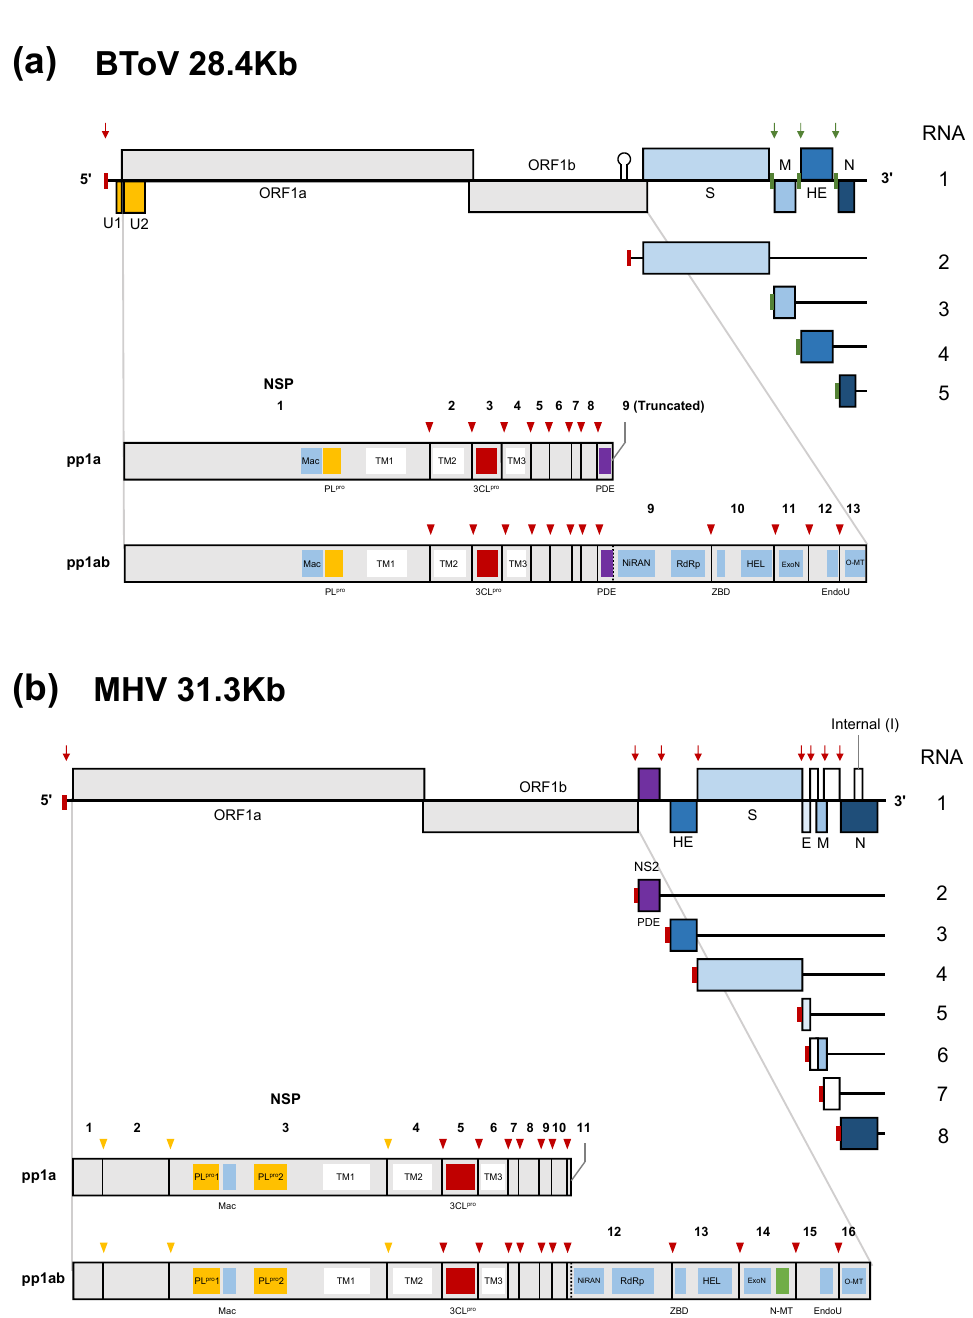
Figure 2. Genome organisation and gene expression of ( a ) BToV and ( b ) MHV (lineage A beta-CoV). The subgenomic (sg) mRNA species are numbered from large to small, with the genome designated RNA1. BToV and MHV polyprotein processing of pp1a and pp1ab and the conserved domains of nonstructural proteins (nsps) are shown. U1 and U2 proteins may be translated from an unconventional CUG initiation codon. The internal (I) protein is encoded within the N gene in some beta-CoVs. The 5 (cid:48) -leader sequence present in the genome and sg mRNA 2 of ToV and the 5 (cid:48) -leader sequence of CoV in all RNA species are indicated by a small red box, and terminator/promoter signals of ToV in sg mRNA3 to 5 by a small green box. Red and green arrows indicate the locations of transcription-regulating sequences (TRSs). Arrowheads indicate (deduced) cleavage sites by papain-like (orange) or 3C-like protease/main protease (red). Vertical dashed line shows a ribosomal frameshifting site. 3CL pro , 3C-like protease (main protease); EndoU, endoribonuclease; ExoN, exoribonuclease; HEL, helicase; Mac, macrodomains including ADP-ribose-1”phosphatase; NiRAN, nidovirus RdRp-associated nucleotidyltransferase; N-MT, guanosine N7-methyltransferase; O-MT, ribose 2 (cid:48) -O-methyltransferase; PDE, 2’, 5’-phosphodiesterase; PL pro , papain-like protease; RdRp, RNA-dependent RNA polymerase; TM, transmembrane domain; ZBD, zinc-binding